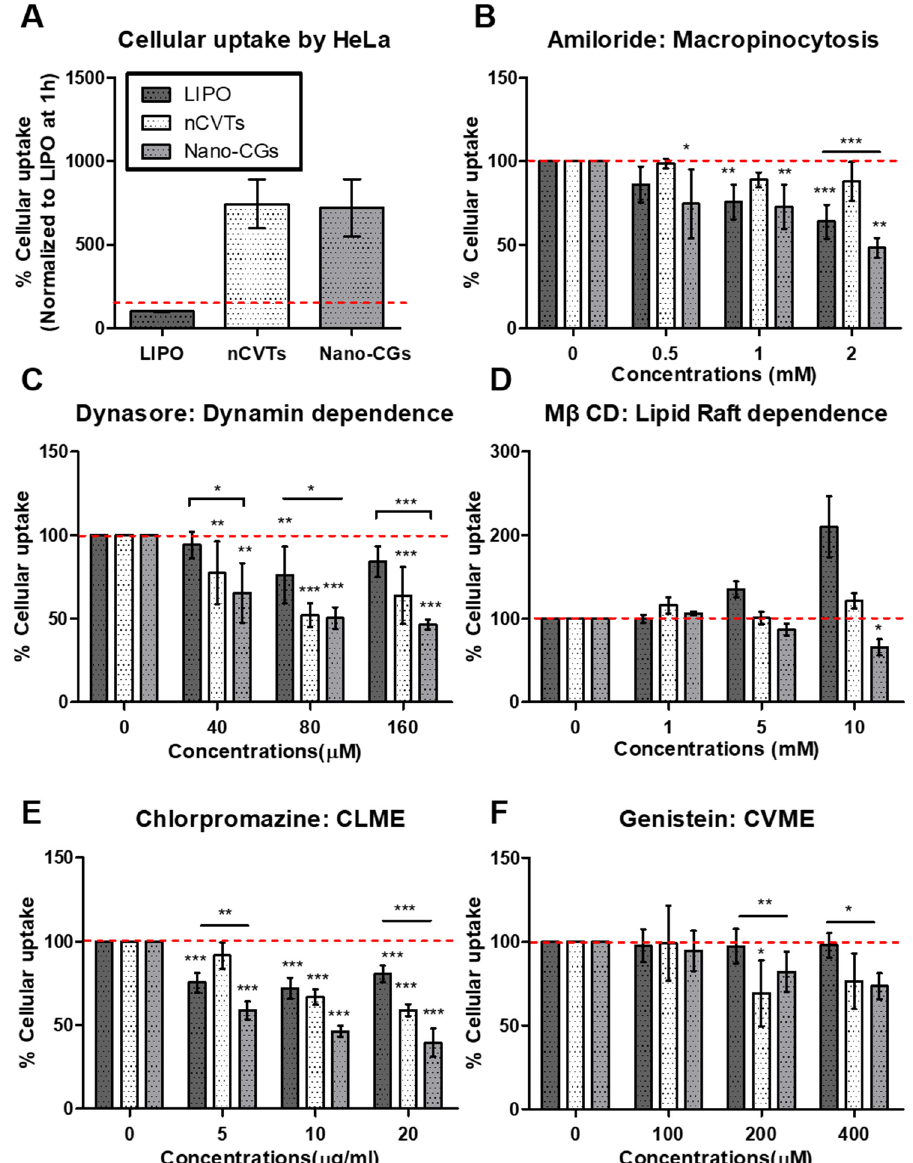
Figure 5. Cellular uptake of liposomes (LIPOs) nCVTs and nano-CGs by HeLa cells ( A ) in absence of inhibitors and the presence of ( B ) amiloride, ( C ) dynasore, ( D ) methyl- β cyclodextrin (M β CD), ( E ) chlorpromazine, and ( F ) genistein; ( n = 5/group) * p < 0.05, ** p < 0.01, and *** p < 0.001.